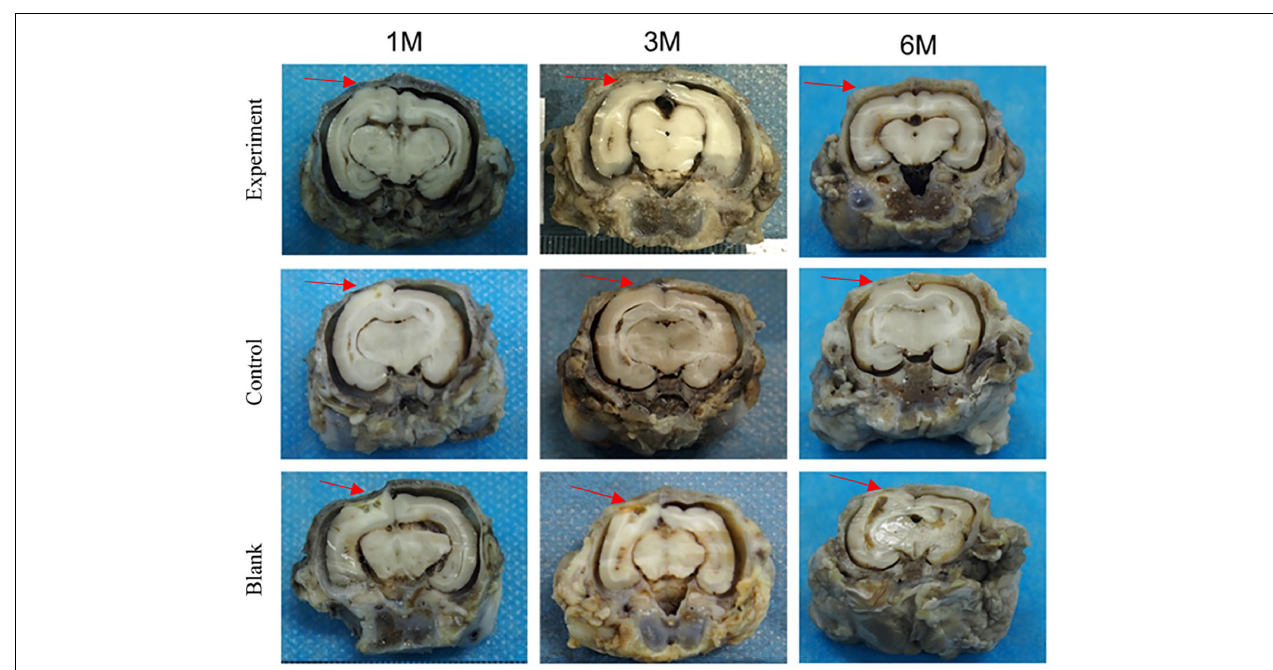
FIGURE 6 | The macroscopic examination of the implants (arrow: implant position).